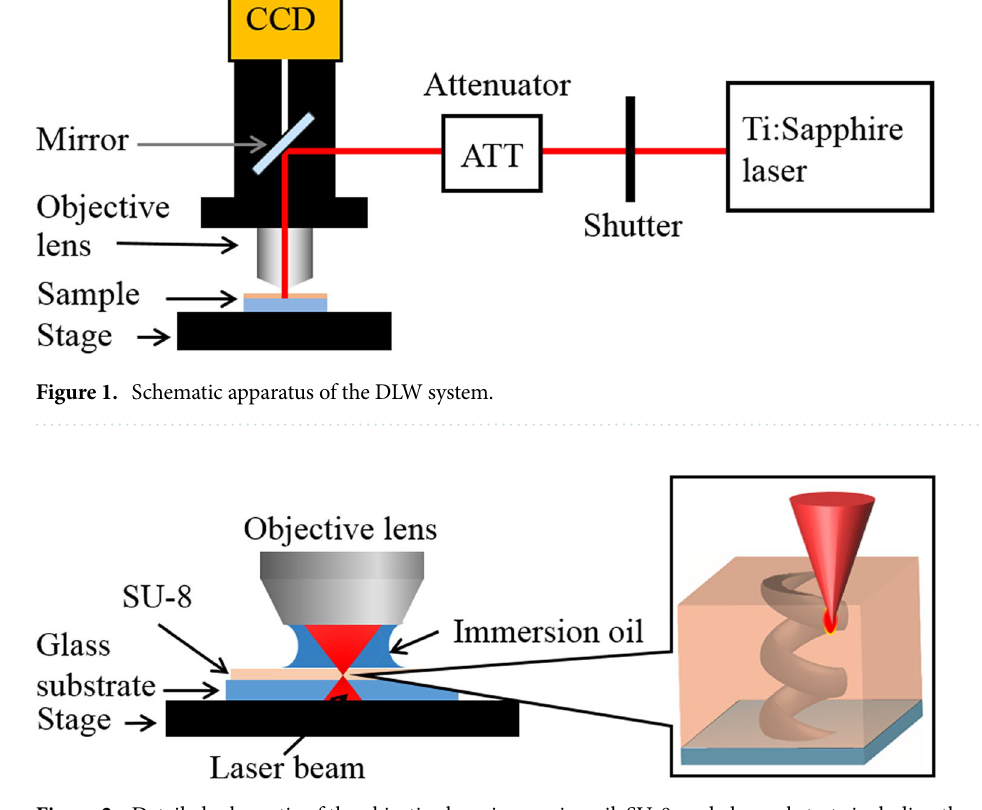
Figure 2. Detailed schematic of the objective lens, immersion oil, SU-8, and glass substrate including the focusing point. Illustration on the right shows the helix microstructure fabricated by DLW in the SU-8 negative